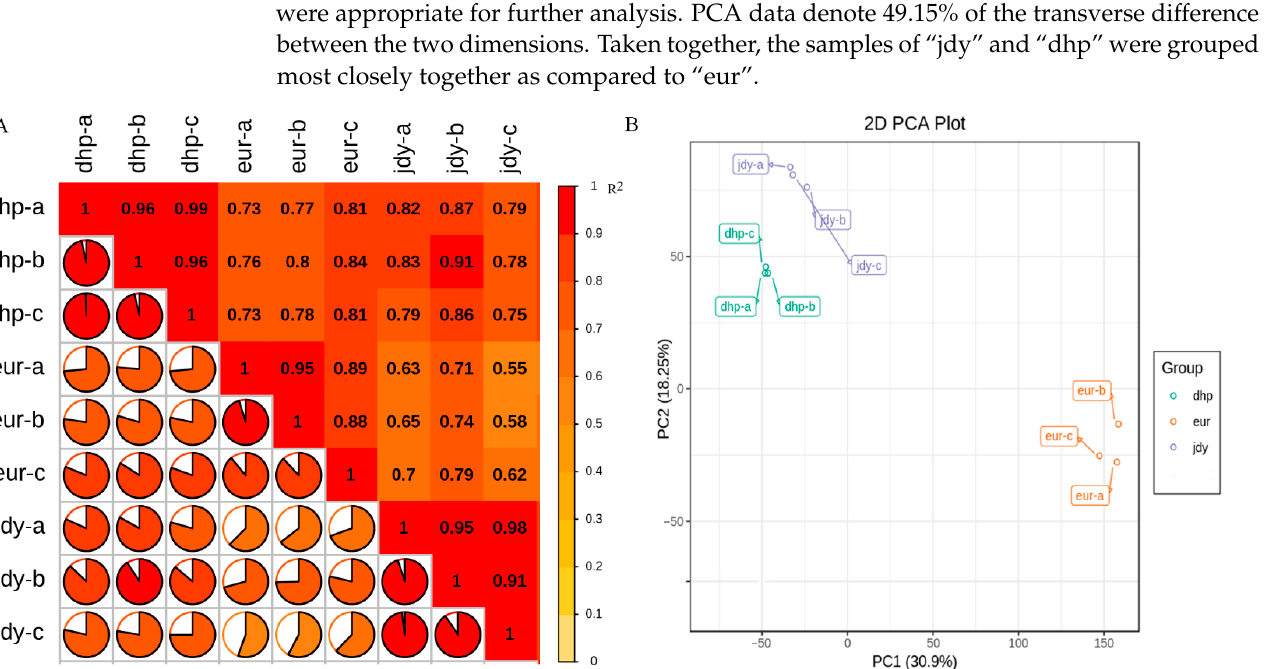
Figure 3. Pearson correlation matrix ( A ) and principal-component analysis ( B ) of differentially expressed genes (DEGs) were performed on sequenced sample sets to assess correlations and variance between samples. “dhp,” “eur,” and “jdy” are the names of the three chestnut cultivars. a/b/c represent the 3 biological replicates.